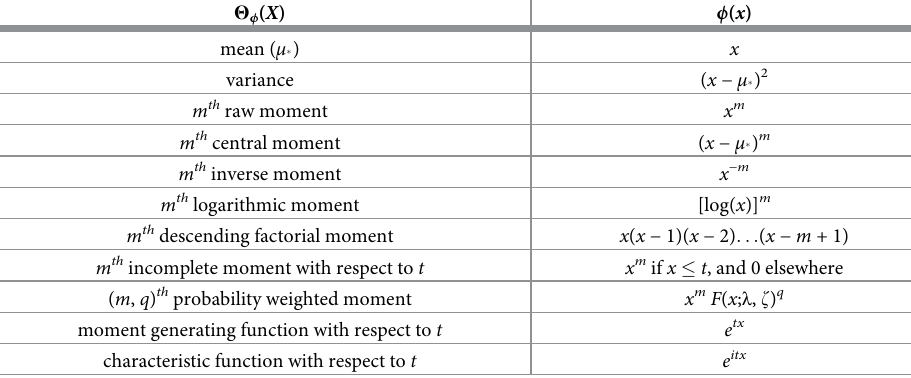
Table 1. Specific measures and functions derived to Θ ( X ) according to the choice of ϕ ( x ). ϕ Θ ϕ ( X ) ϕ ( x ) mean ( μ � ) x variance ( x − μ � ) 2 m th raw moment x m m th central moment ( x − μ � ) m m th inverse moment x − m m th logarithmic moment [log( x )] m m th descending factorial moment x ( x − 1)( x − 2) ... ( x − m + 1) m th incomplete moment with respect to t x m if x � t , and 0 elsewhere ( m , q ) th probability weighted moment x m F ( x ; λ , z ) q moment generating function with respect to t e tx characteristic function with respect to t e